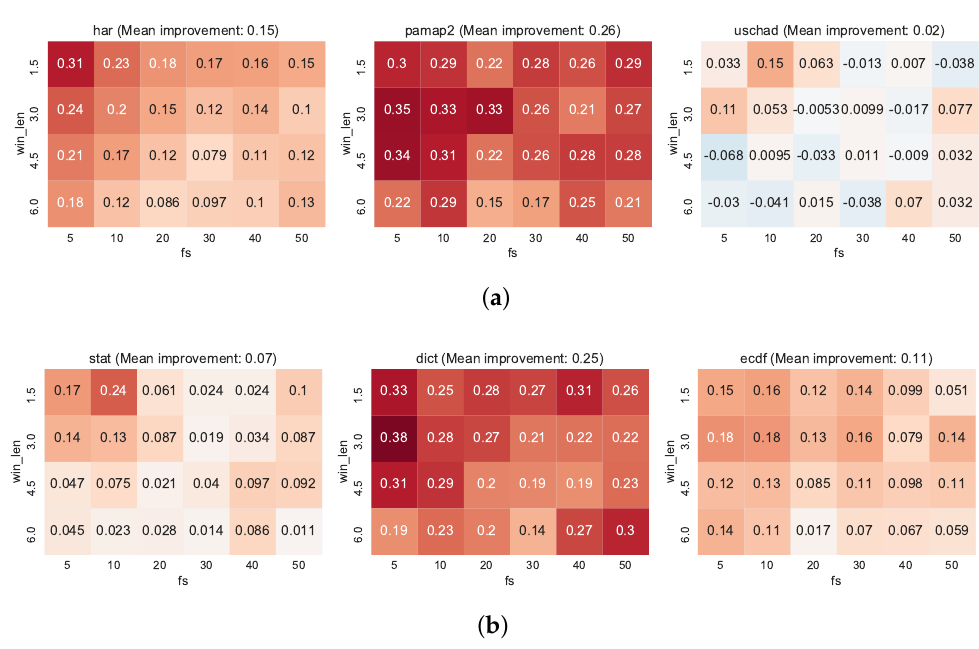
Figure 10. Mean aggregated change in performance when aggregated over datasets ( a ) and features ( b ). ( a ) Mean improvement of Conditional Random Fields (CRFs) aggregated over datasets. ( b ) Mean improvement of Conditional Random Fields (CRFs) aggregated over